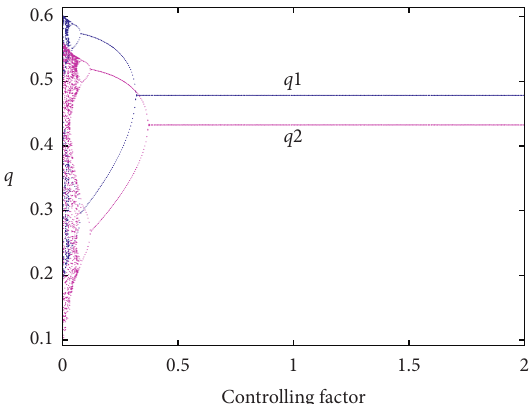
Figure 16: The bifurcation diagram of the controlling factors.